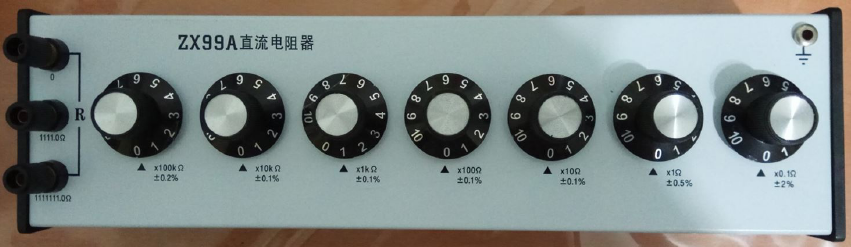
Figure 15. The DC resistance controller ZX99A [20] was used to provide the reference resistance to validate the performance of reading resistance from the A-meter by the proposed